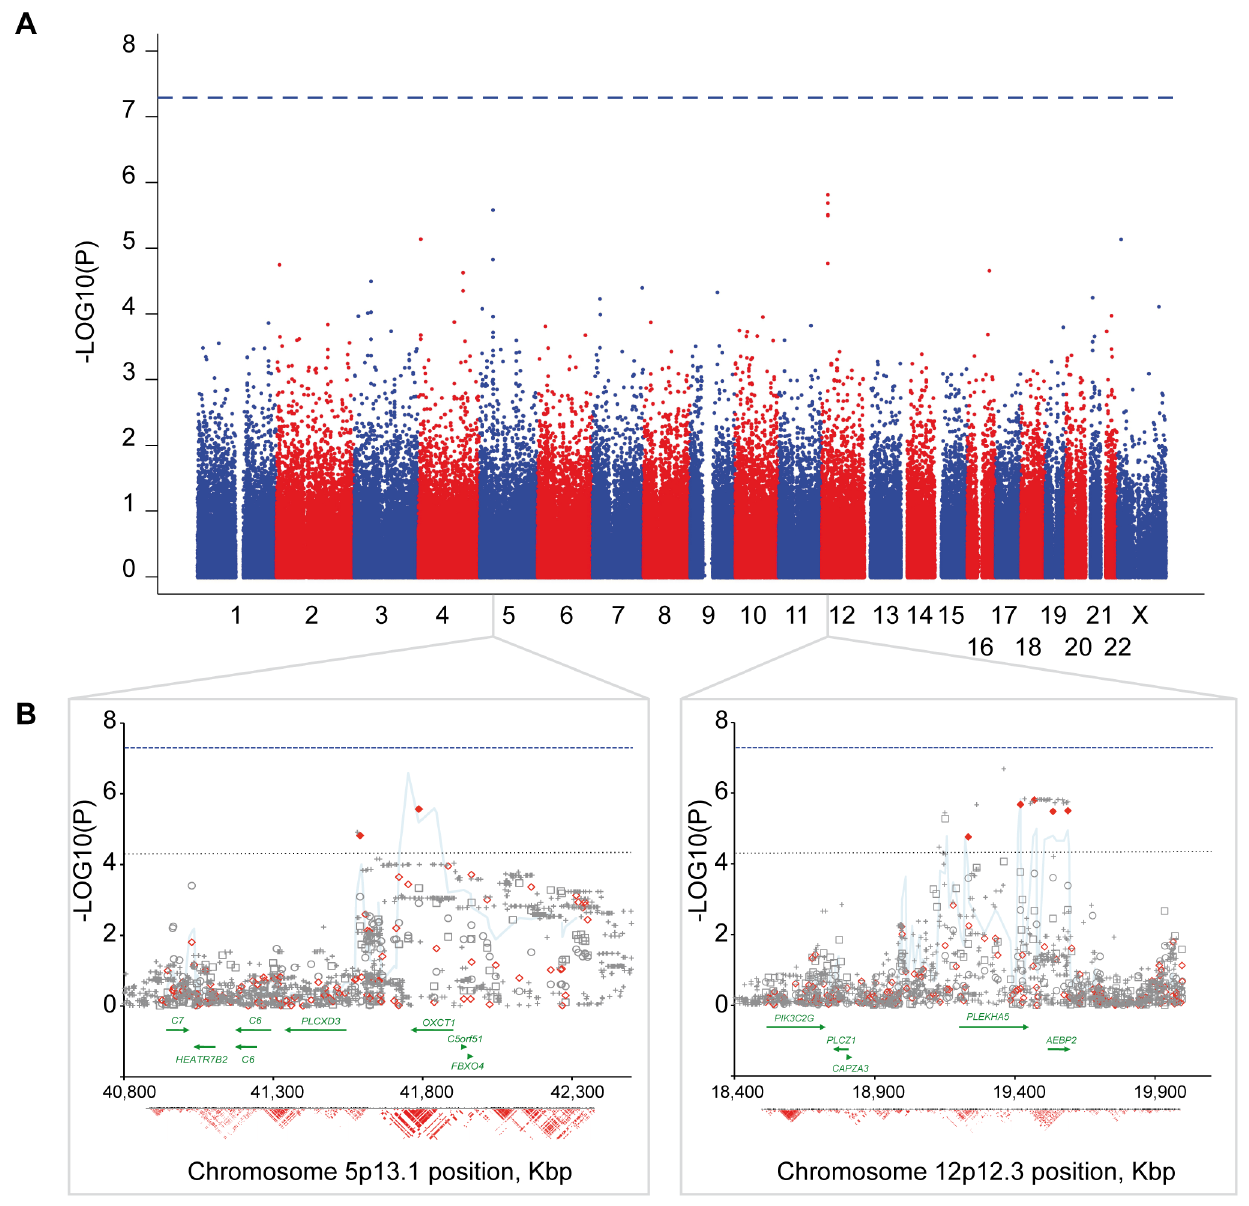
Figure 1. Genome-wide association results and detailed peak association regions. ( A ) Manhattan plot of the meta-analysis performed on early-onset bipolar patients and controls from France and Germany. Physical position is shown along the x axis and –log10( P -value) is shown along the y axis. ( B ) Detail of the two most associated regions on chromosomes 5p13 and 12p12. Allele frequency differences are represented by –log10( P - values) for the French (open grey circles), the German (open grey squares) and the meta- (open red diamonds) analyses. Grey crosses represent – log10( P -value) for imputed ungenotyped SNPs. The most associated SNP for each region is shown with orange circle. On chromosome 12p12, the lowest P -value ( P =2.1 6 10 2 7 ) was observed for an imputed SNP ( rs10743315 ). On chromosome 5p13, the lowest P -value ( P =2.6 6 10 2 7 ) was observed for a three-SNPs window haplotype (light blue line) located downstream to OXCT1 and upstream to PLCXD3 ( rs624097-rs316762-rs10512793 ). The genome-wide significant threshold ( P =5 6 10 2 8 ) is indicated by the blue dash line and the dot black line shows a threshold at P =5 6 10 2 5 . The largest differences in allele frequencies are represented with filled diamonds. Gene position and annotation (http://genome.ucsc.edu/) are symbolised by green arrows. Linkage disequilibrium (r 2 ) estimated according to HapMap CEU population SNPs (release 3) is symbolised in the bottom part of each figure. Darker red indicates higher values.